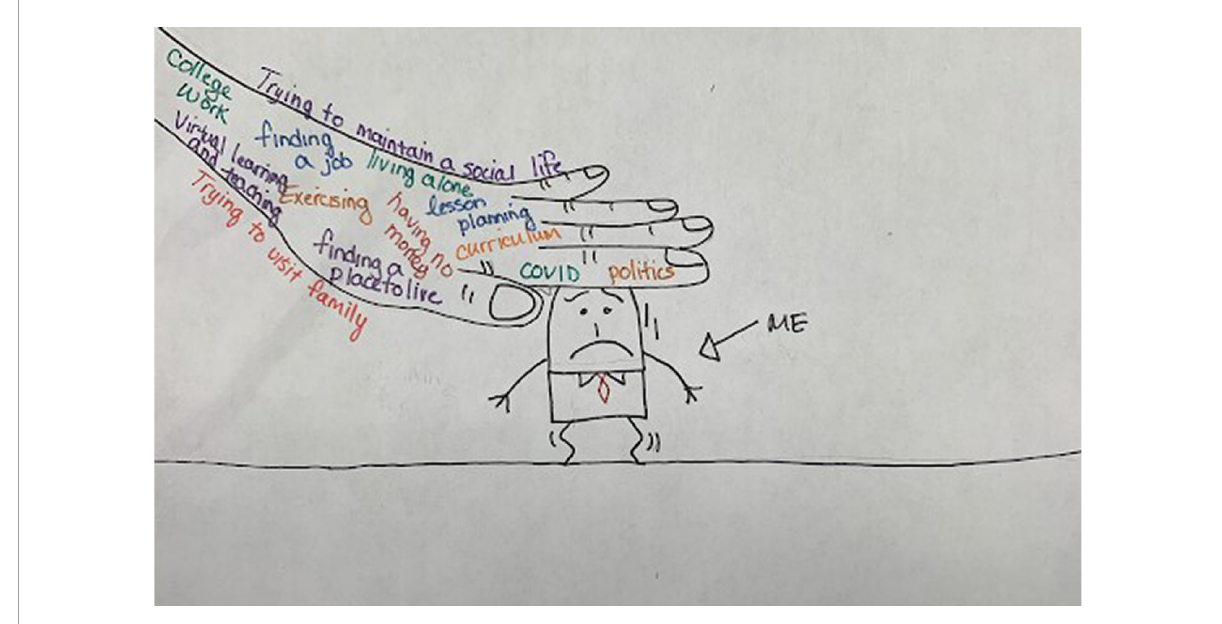
FIGURE3 Under pressure, Fall